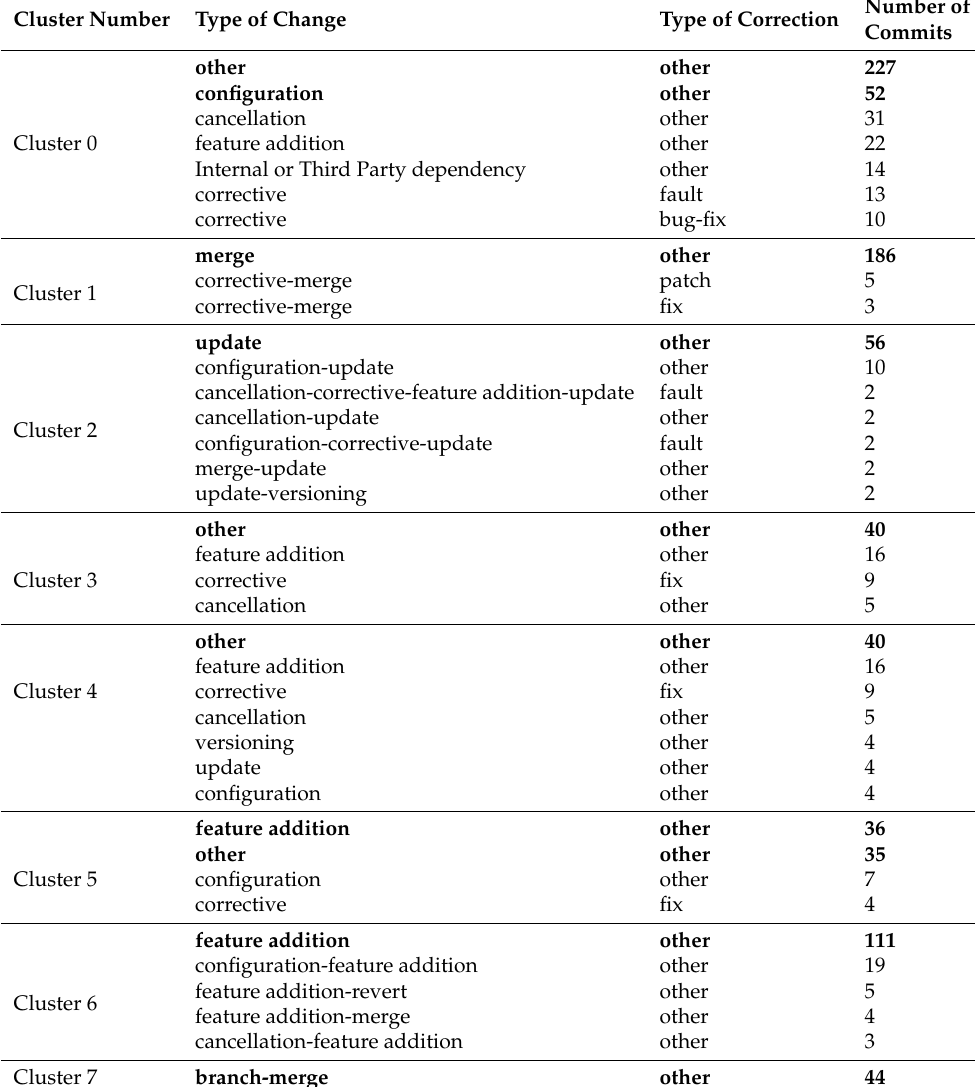
Table 7. Type of commits per